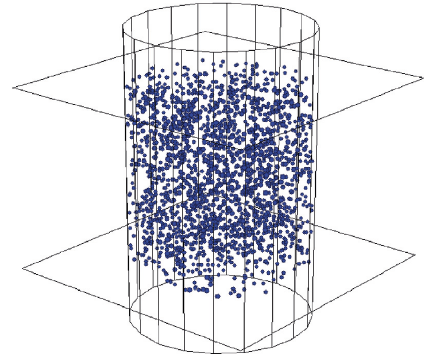
Figure 7: Distribution of air voids. (a) Entire model. (b) Vertical section view. (c) Transverse section